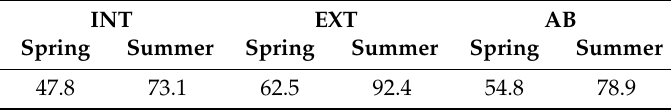
Table 2. Ratio (%) of root colonization by fungi colonies on the sampled vineyards rhizosphere. INT EXT AB Spring Summer Spring Summer